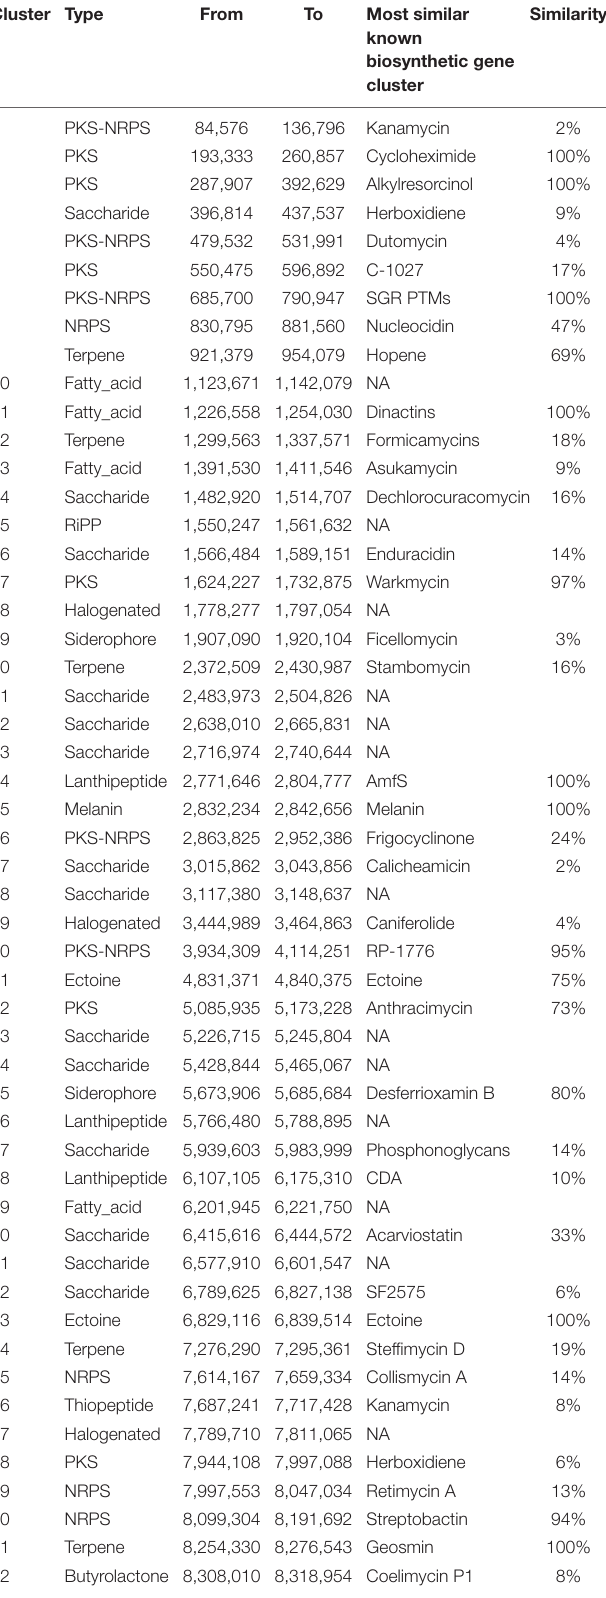
TABLE 4 | Secondary metabolite clusters in strain